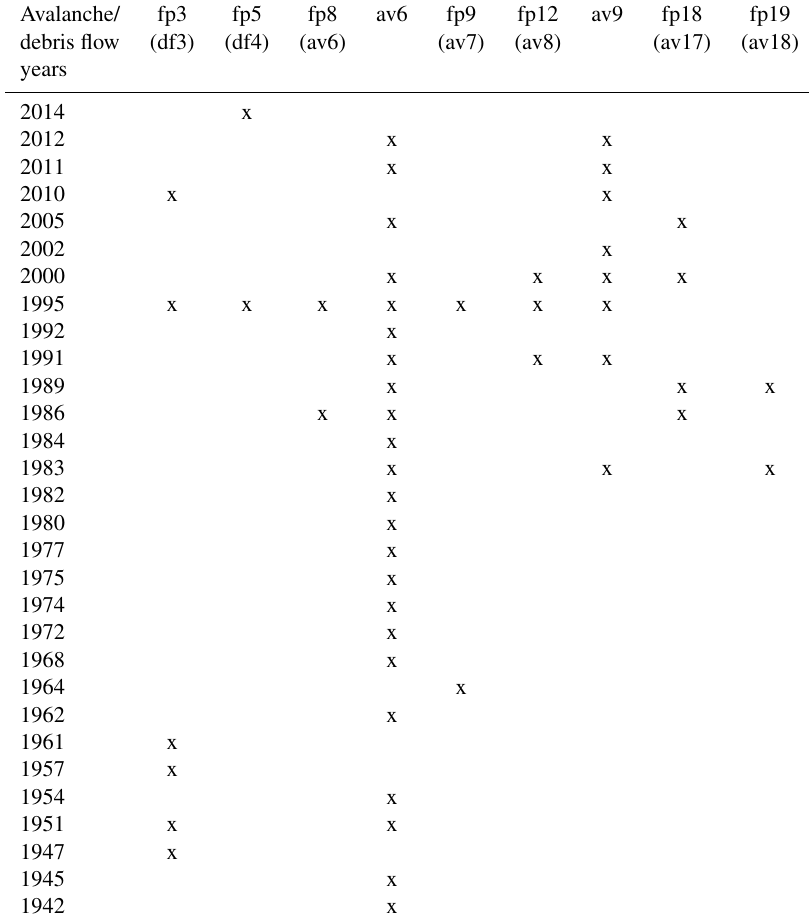
Table 2. Reconstructed avalanche and debris flow events at the investigation area. Fp3 and fp5 show event years in the debris flow tracks (df3 and df4), whereas fp8, av6, fp9, fp12, av9, fp18 and fp19 show event years at different avalanche tracks (av6, av6, av7, av8, av9, av17 and